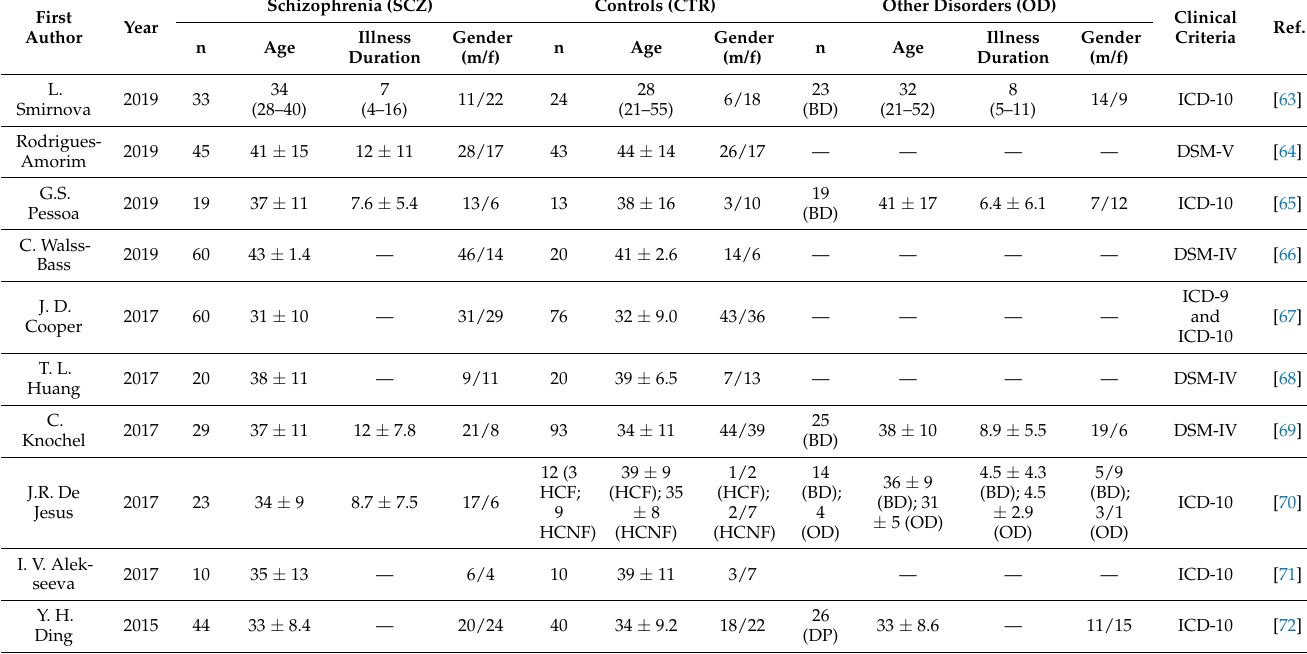
Table 1. Demographic summary of all the studies included in the systematic review of Schizophrenia and biomarkers discovery using MS-based method in human peripheral